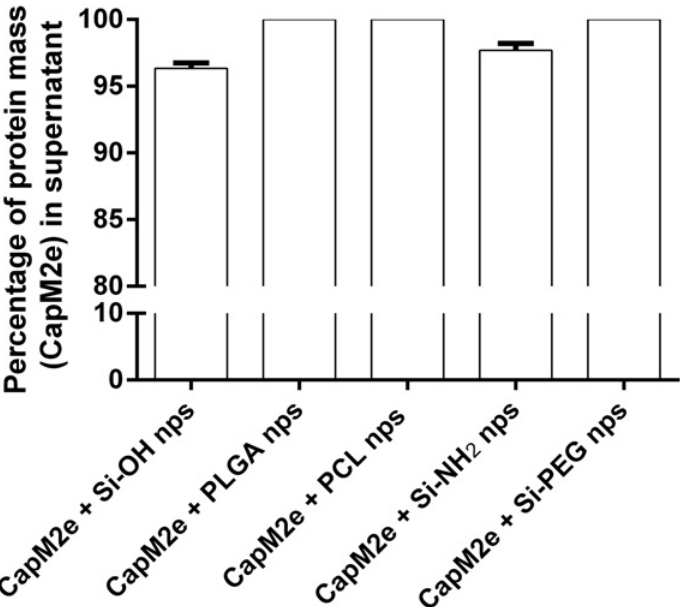
Fig 2. Percentage of protein mass (CapM2e) in supernatant after mixing with different nanoparticle solutions.